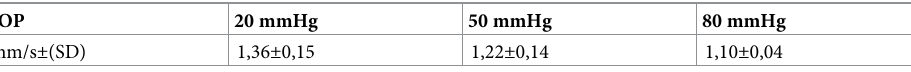
Table 1. Injection speed at 20, 50 and 80